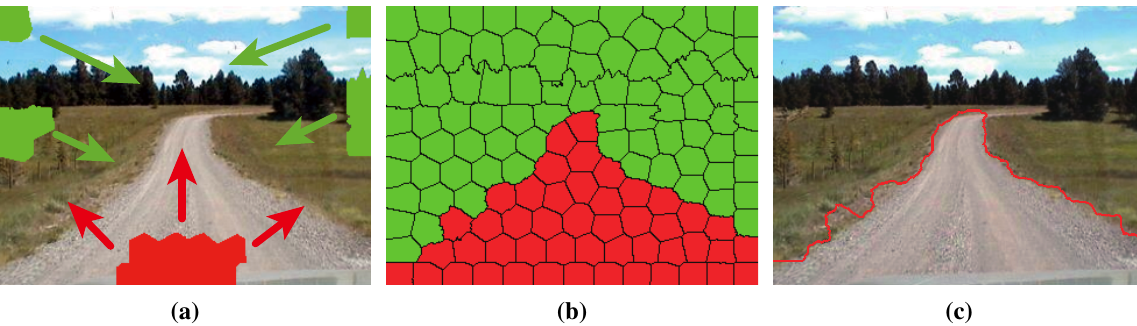
Figure 12. Illustration of segmentation using GrowCut: ( a ) the proliferation of seeds; ( b ) the convergence of the iteration; ( c ) the contour of the obtained road